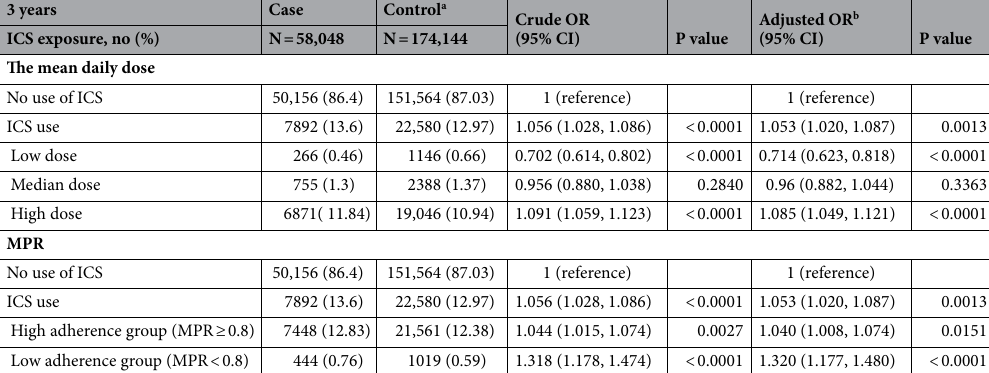
High adherence group (MPR ≥